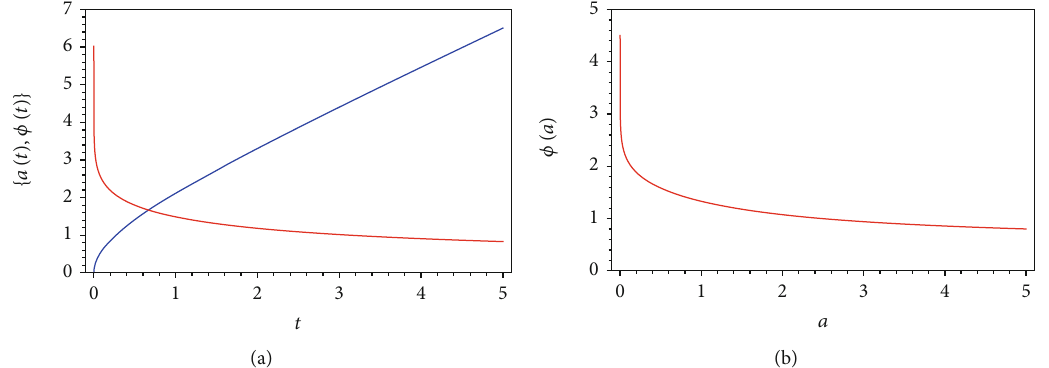
Figure 3: (a) The behavior of the scale factor (blue line) and scalar fi eld (red line) in the early times of cosmic evolution. (b) The corresponding classical trajectory in the plane a − ϕ . The fi gures are plotted for numerical values: g = 1/2